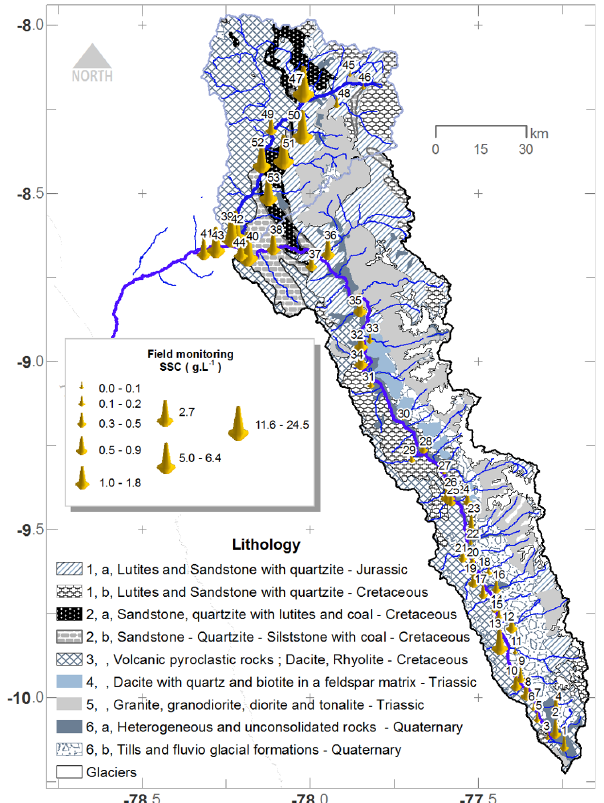
Fig. 2. Lithology map of the Santa and Tablachaca study catchments according to six formations (details in Table 1). Cones size ac- cording to suspended sediment concentration amount (SSC, gL − 1 ) sampled during the wet season (February–March 2009; see Table 2 for